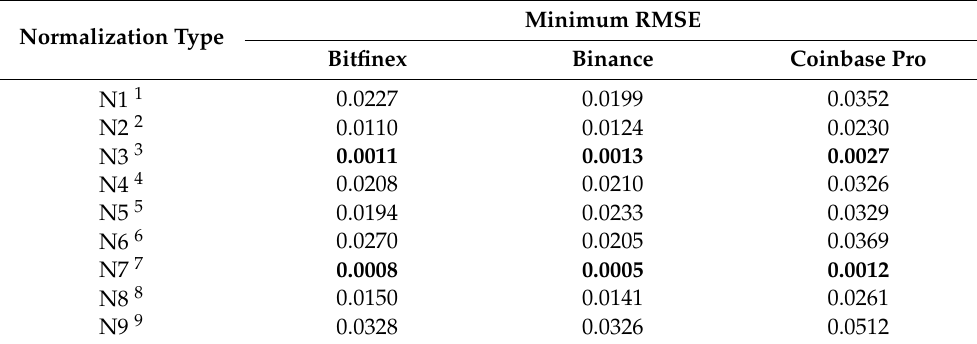
Table 3. Minimum root mean square error for each normalization based Legendre neural network for 3